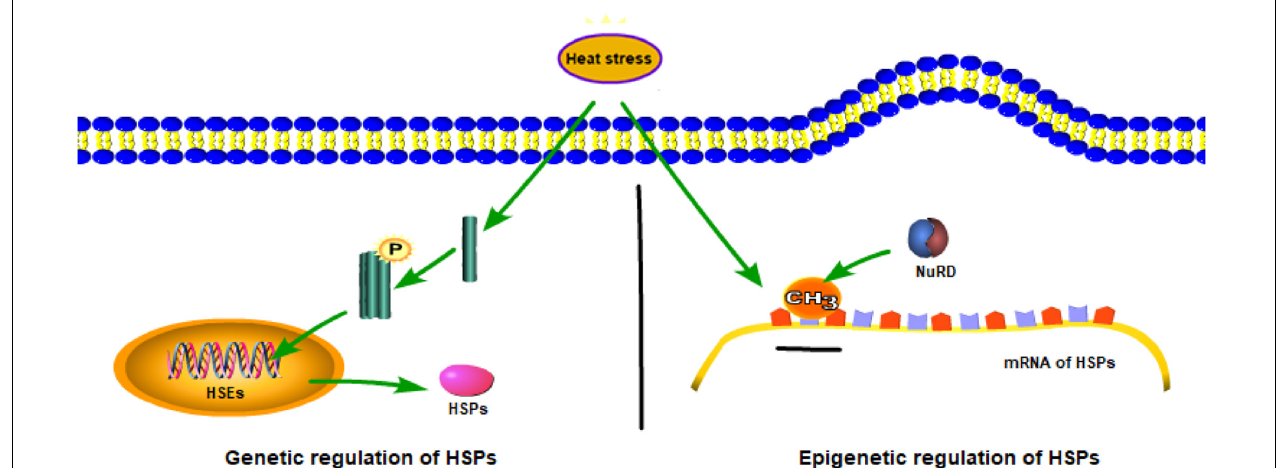
FIGURE 2 | Genetic and epigenetic mechanisms of heat-shock protein family (HSP)